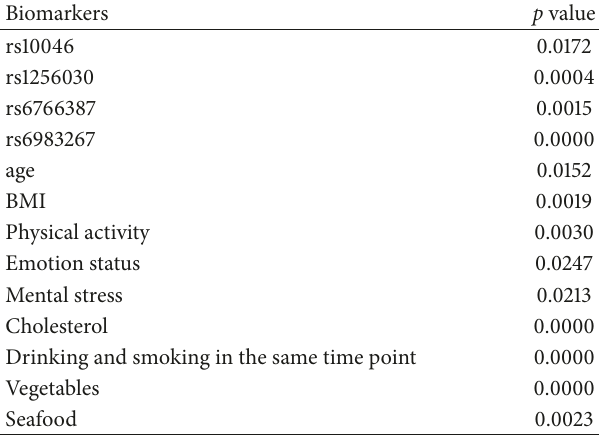
Table 5: p value of 13 important biomarkers.